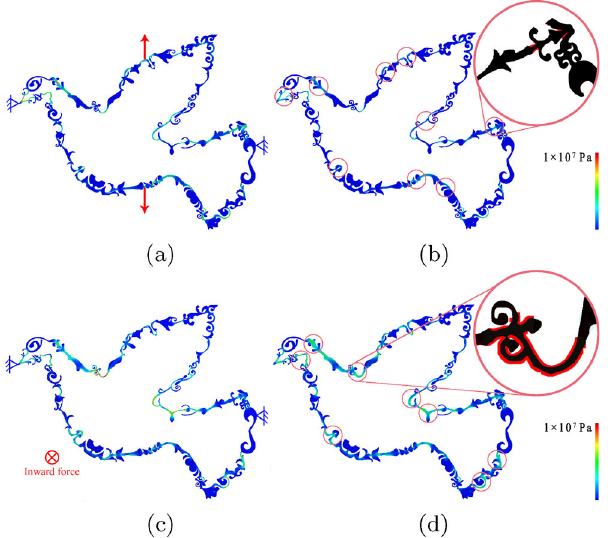
Fig. 7 Structural analysis (a, c) and optimization (b, d) of the shape. Weak parts are strengthened by dilation (circled in red) in (b, d). The shape is colored by stress.